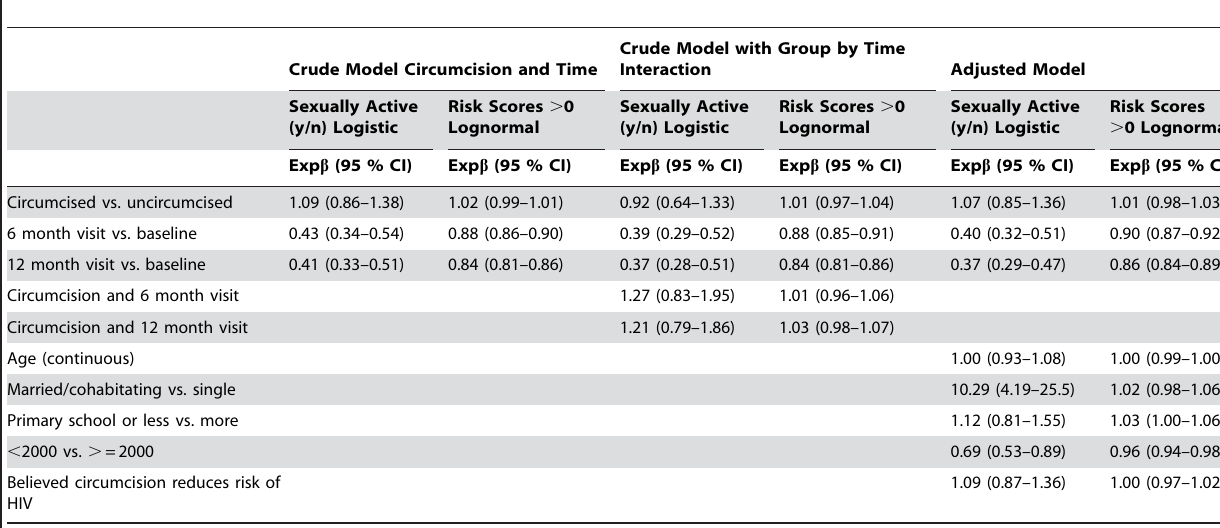
Table 3. Results of the Two-Part Random Effects Regression Modeling the Sexual Risk Score, Circumcision Status, and Time With and Without Covariates